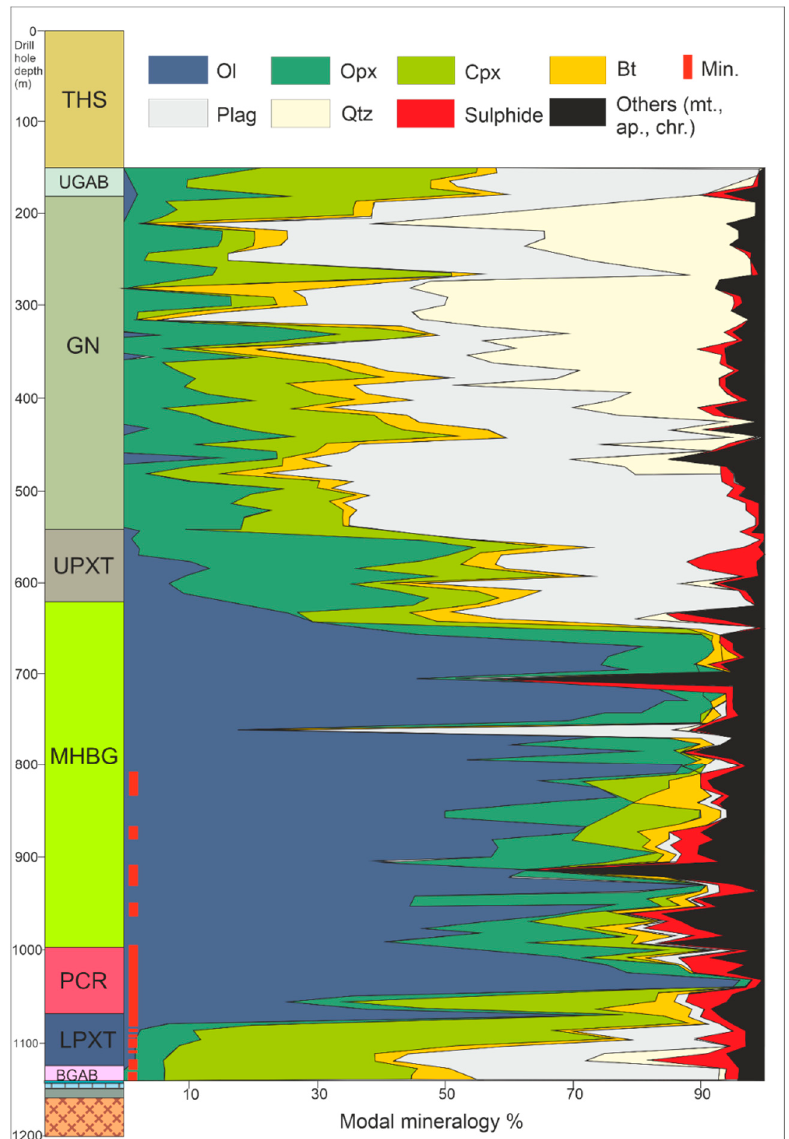
Figure 7. Modal proportions of samples of all rock units of the Uitkomst Complex in borehole LM-6. Abbreviations: Rock units as in Figure 5, Ol = olivine, Opx = orthopyroxene, Cpx = clinopyroxene, Bt = biotite, Plag = plagioclase, Qtz = quartz, Sulphide = base metal sulphides, mt = magnetite, ap = apatite, chr = chromite, Min. = less than 5% base metal sulphide mineralisation, in the Basal Gabbro unit ~10%, indicated by red lines in the lower left of the diagram.